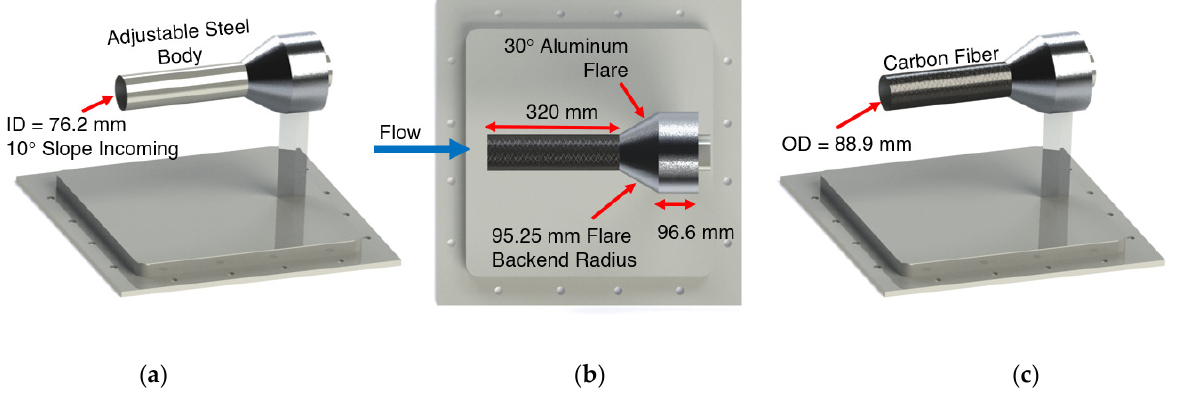
Figure 1. Dimensional schematics of the hollow cylinder flare model, ( a ) smooth surface, ( b ) top view, and ( c ) rough surface.